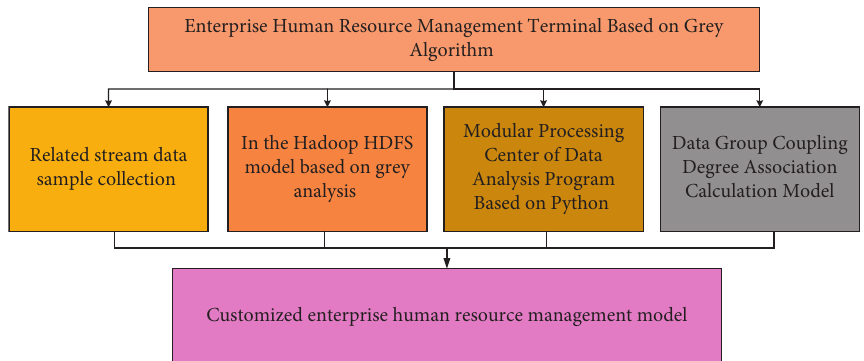
Figure 1: Schematic diagram of enterprise human resource management based on grey